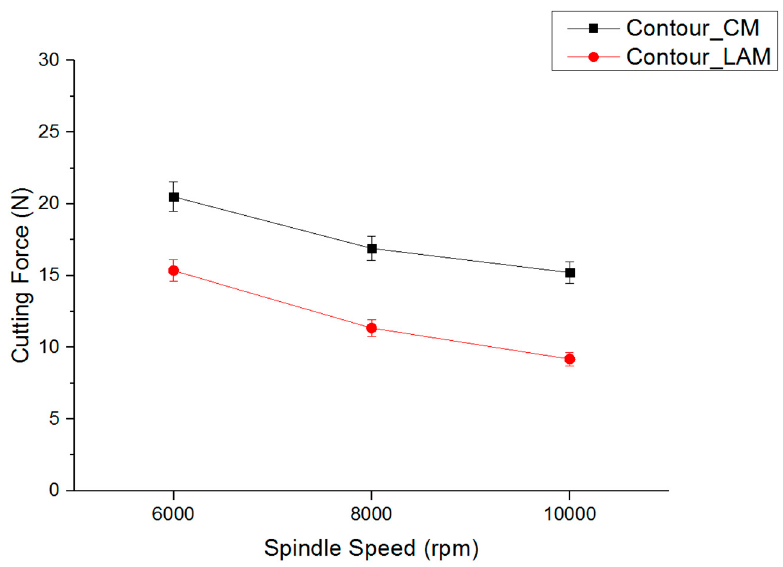
Figure 13. Experiment results by the feed rate 140 mm/min in contour milling.